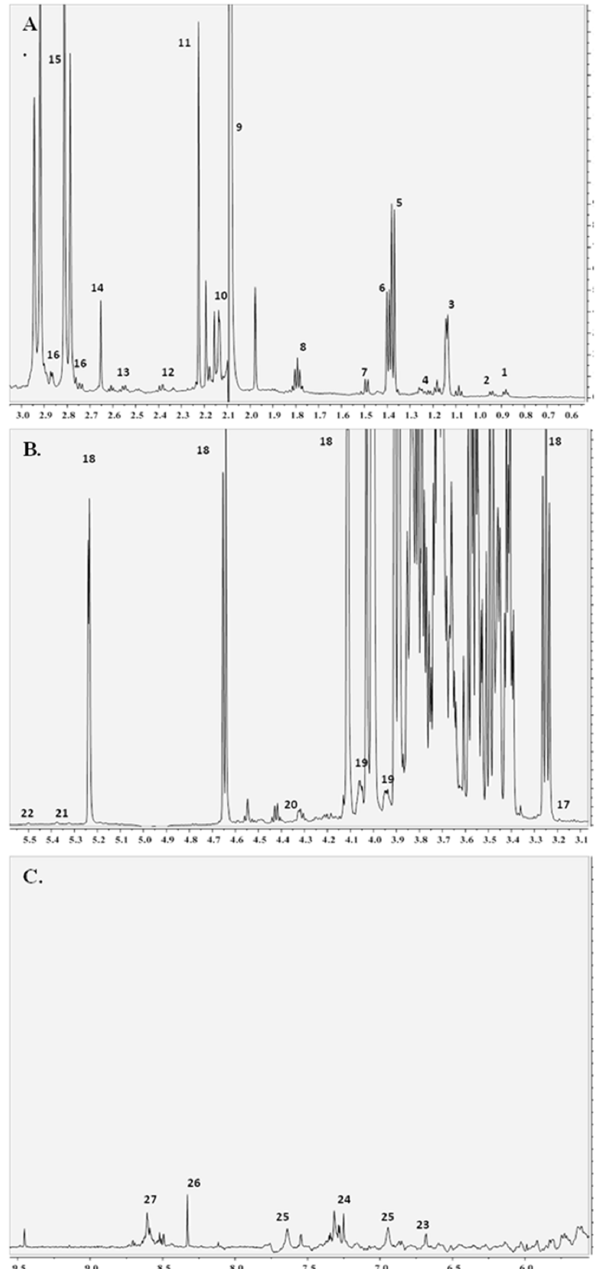
Figure 3. 1 H NMR spectrum of the balsamic vinegar with honey.( A ) ( Peak assignment: 1: leucine,